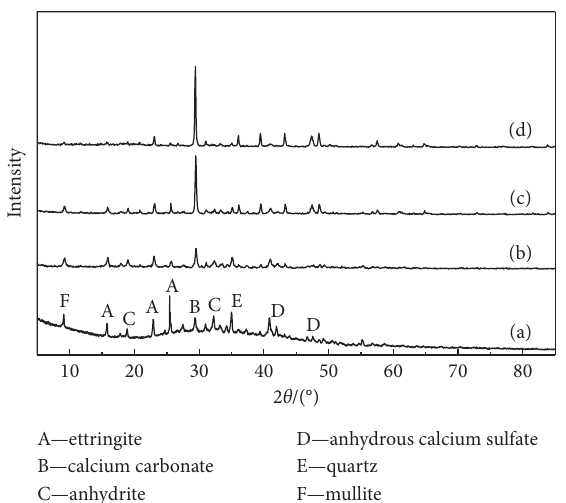
Figure 10: XRD phase analysis of HWM in different states: (a) 4-B-0; (b) the internal of 4-B-12; (c) the surface of 4-B-12; (d) the surface of 4-S-12.